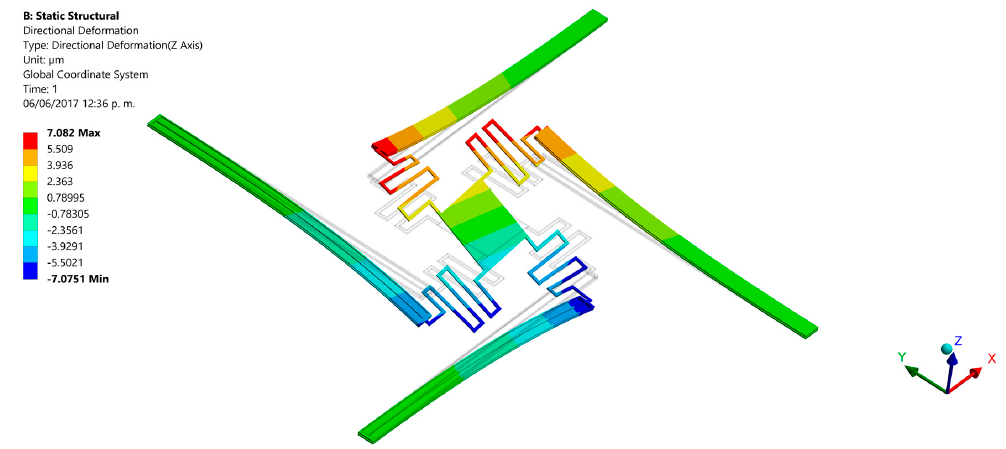
Figure 16. Out-of-plane displacements of the MEMS mirror when four polysilicon electrothermal actuators ( L h = L c = 550 µ m) are biased with 2.5